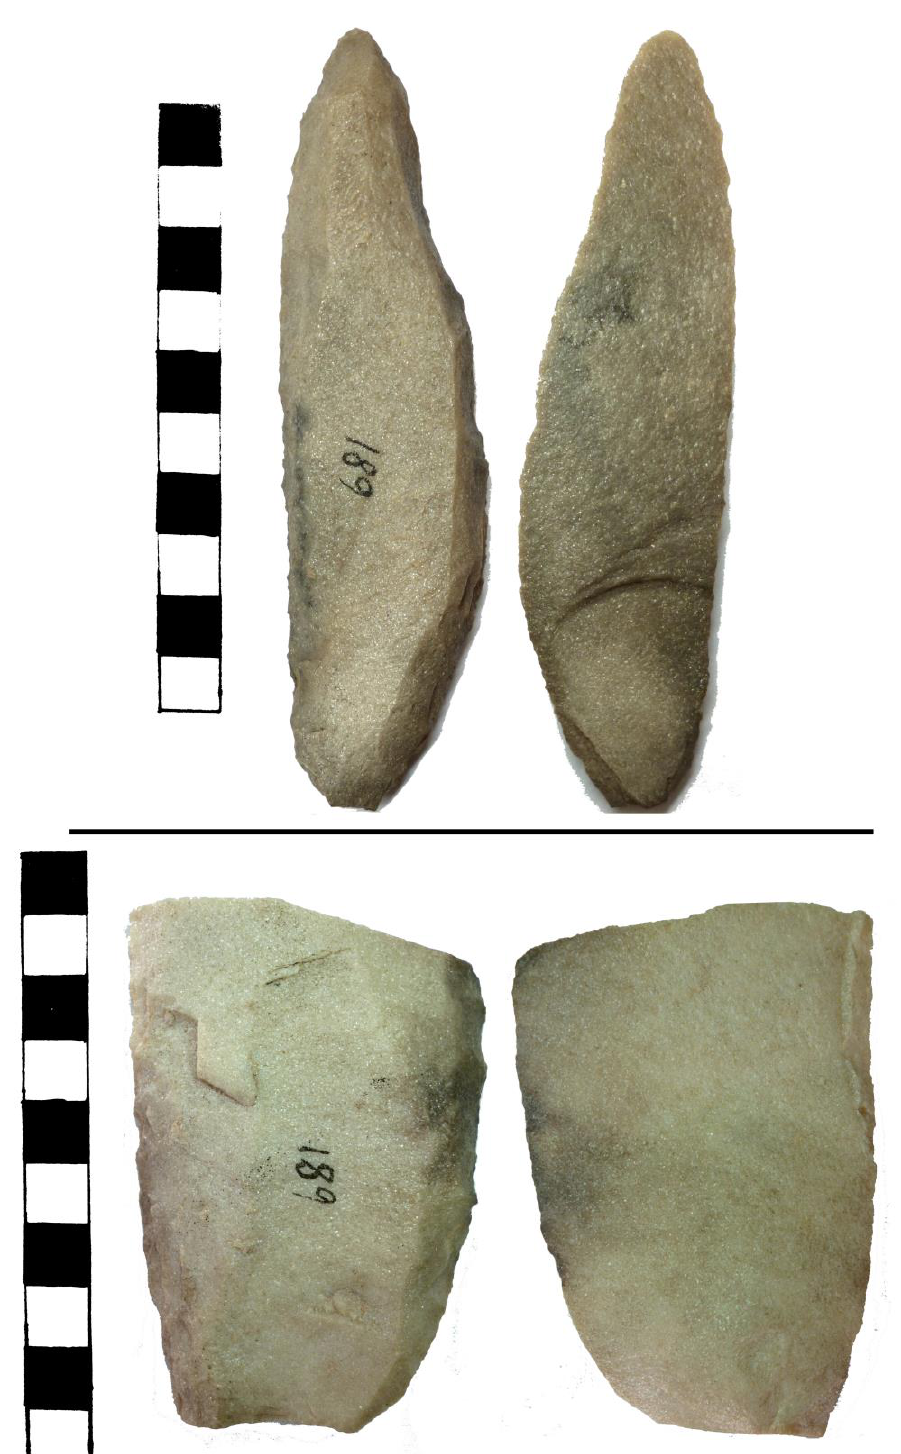
Figure 18. Limaces from Gruta das Araras site. The lower limace is broken at the distal portion. Photos by the